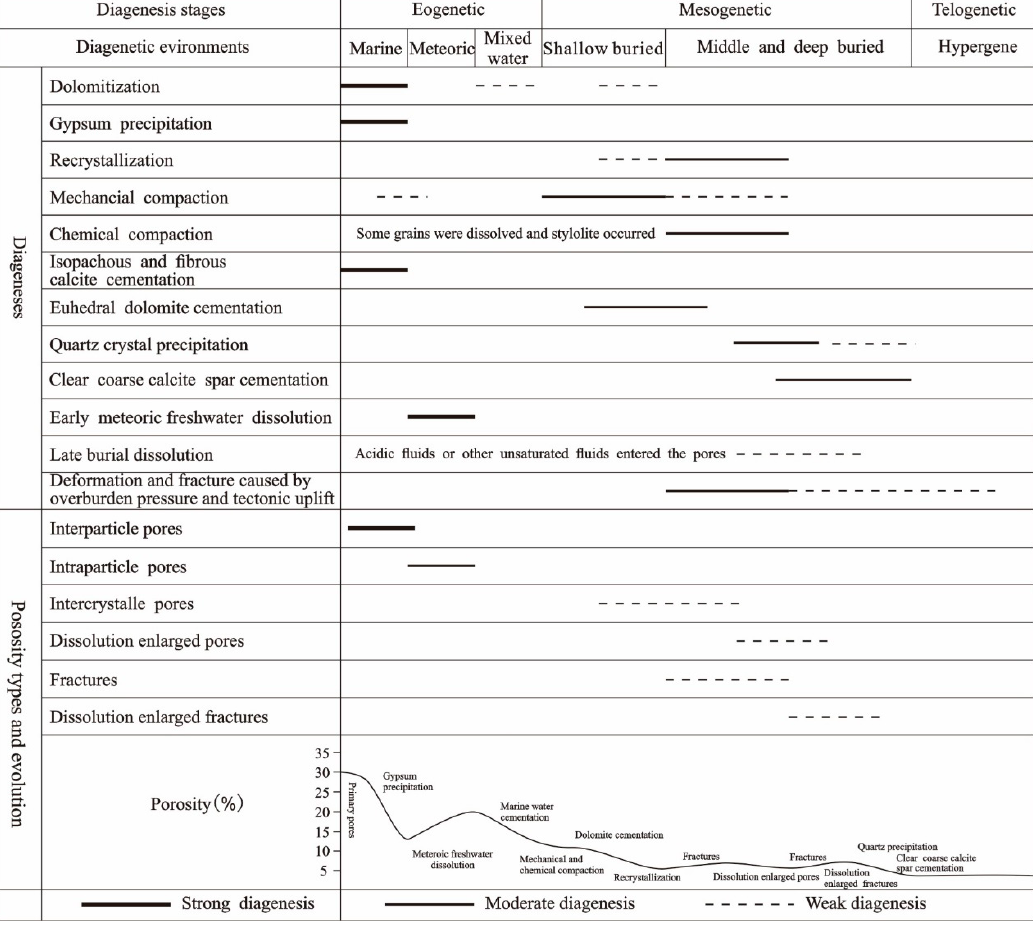
Figure 14. Major diagenesis impacting the reservoir quality of the Leikoupo Formation.